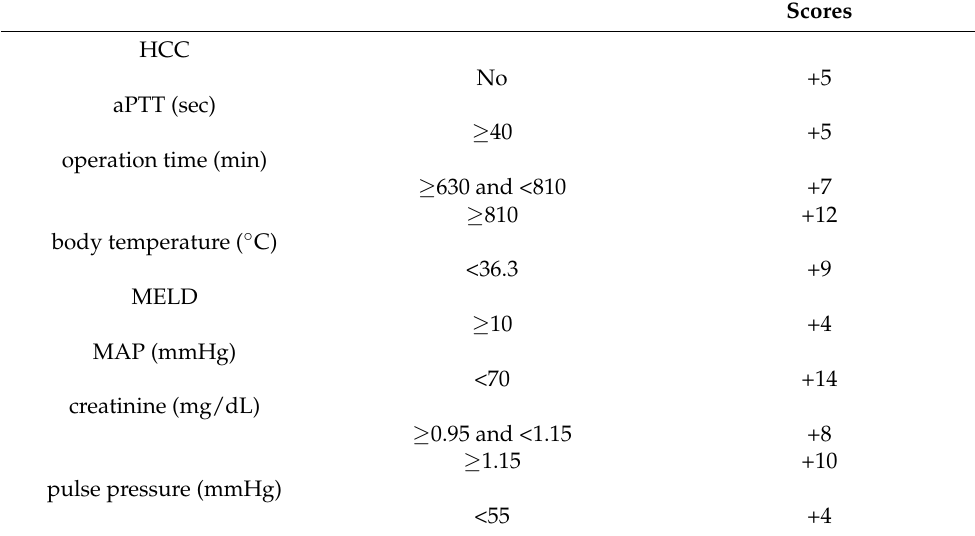
Table 4. Risk scoring